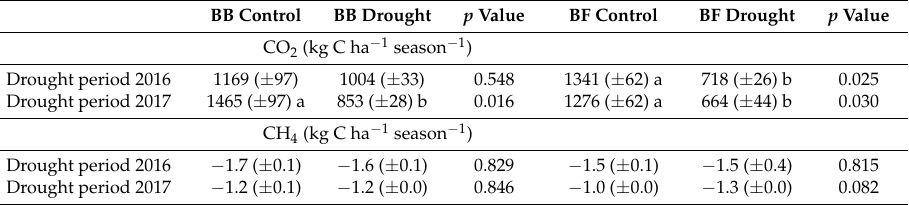
Table 2. The cumulative flux rates of the simulated drought periods (2016: 78 days; 2017: 99 days) of soil respiration (CO 2 ), CH 4 and N 2 O of the control as well as drought treatment of the pure beech (BB) and mixed beech-fir stand (BF); mean ( ± se). Significant differences are indicated by different letters at p < 0.05. BB Control BB Drought p